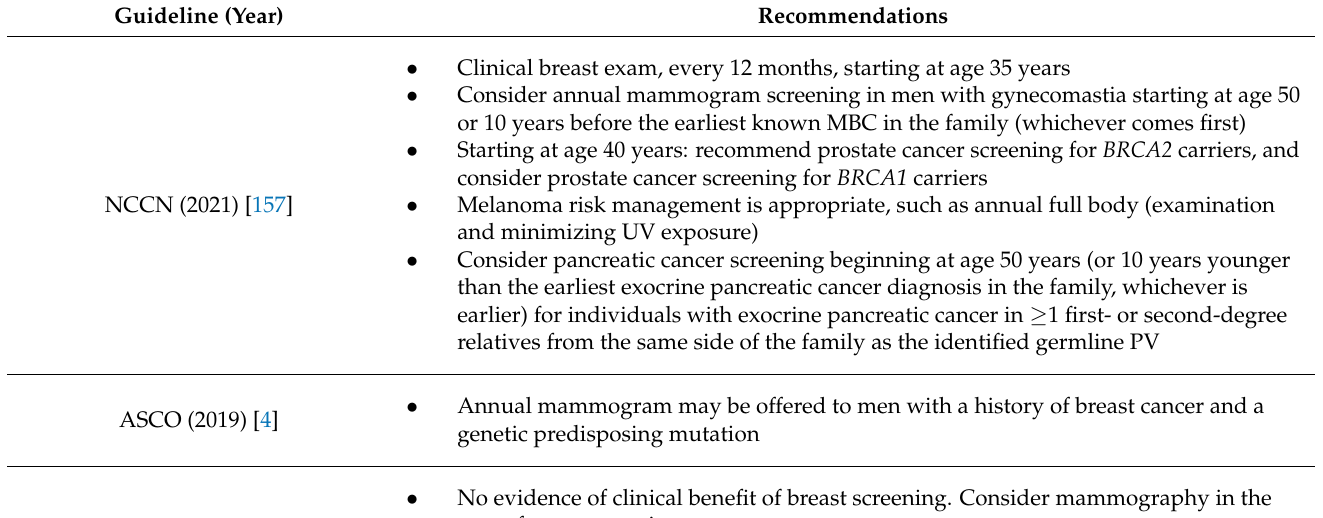
Table 3. Main recommendations of the selected guidelines on the surveillance of male carrier of BRCA1 and BRCA2 PVs. Guideline